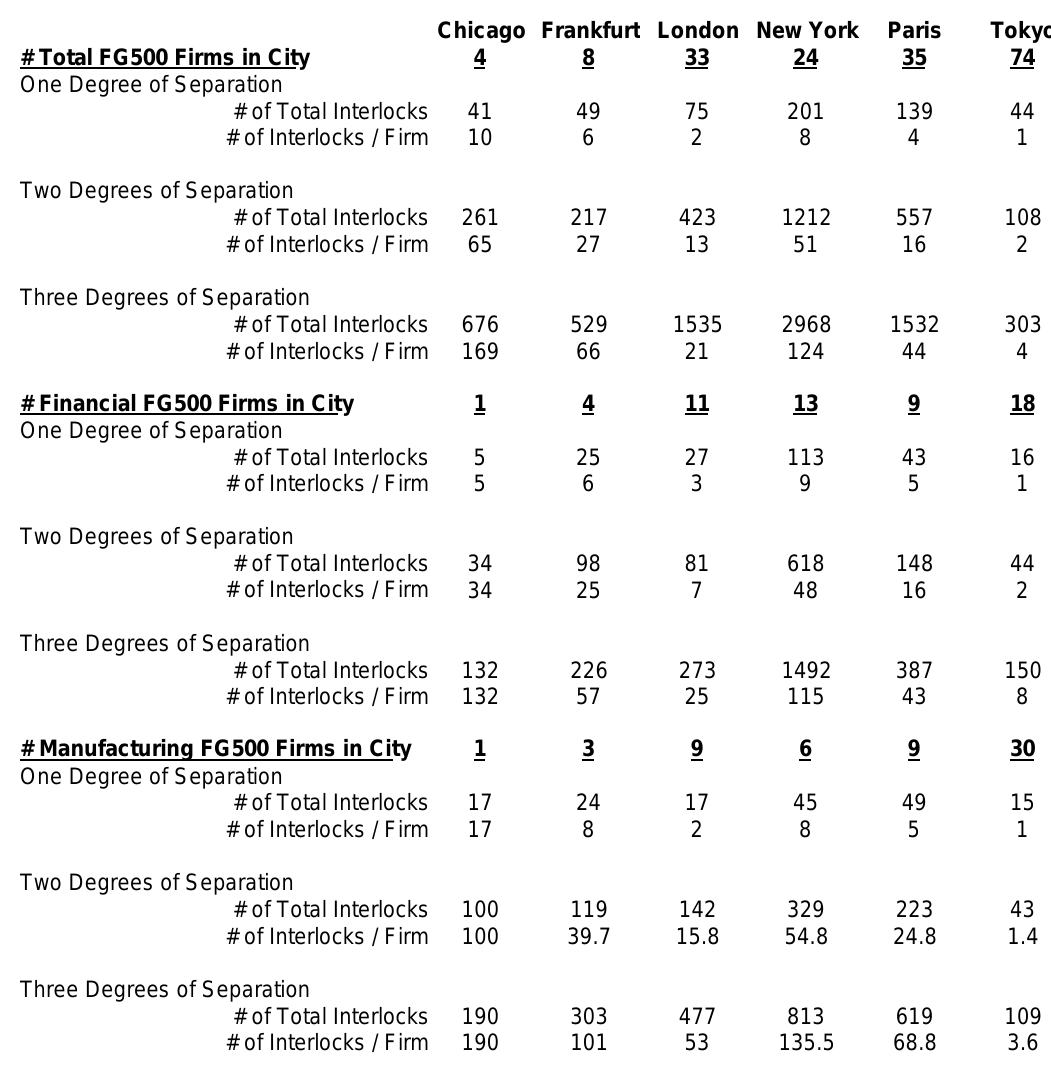
Table 2. Number of Corporate Board Interlocks of FG500 Firms in Selected Cities with Other FG500 Firms in 1998, By